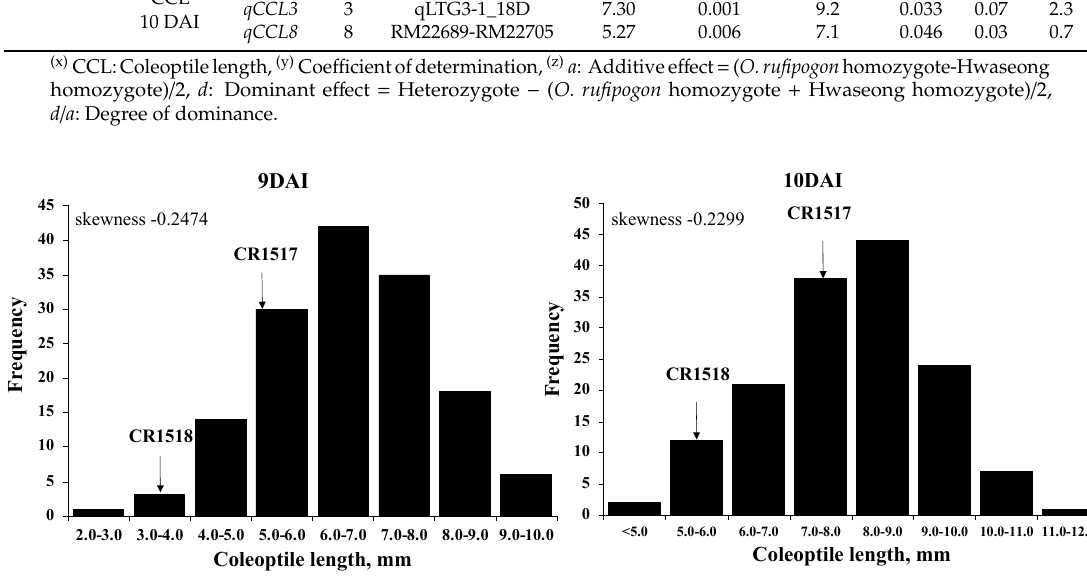
Figure 4. Frequency distribution of coleoptile length in 149 F 2 plants at 13 °C at 9 and 10 DAI. Arrows indicate mean coleoptile length of CR1517 and CR1518 lines.